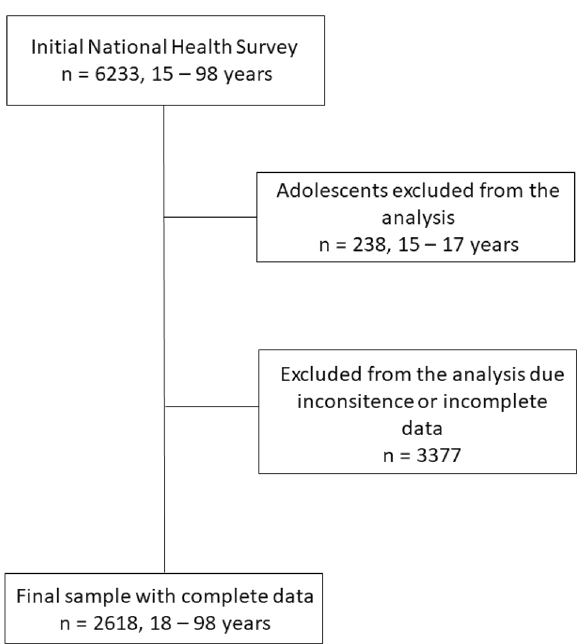
Figure 1. Flow chart of the process to obtain the final